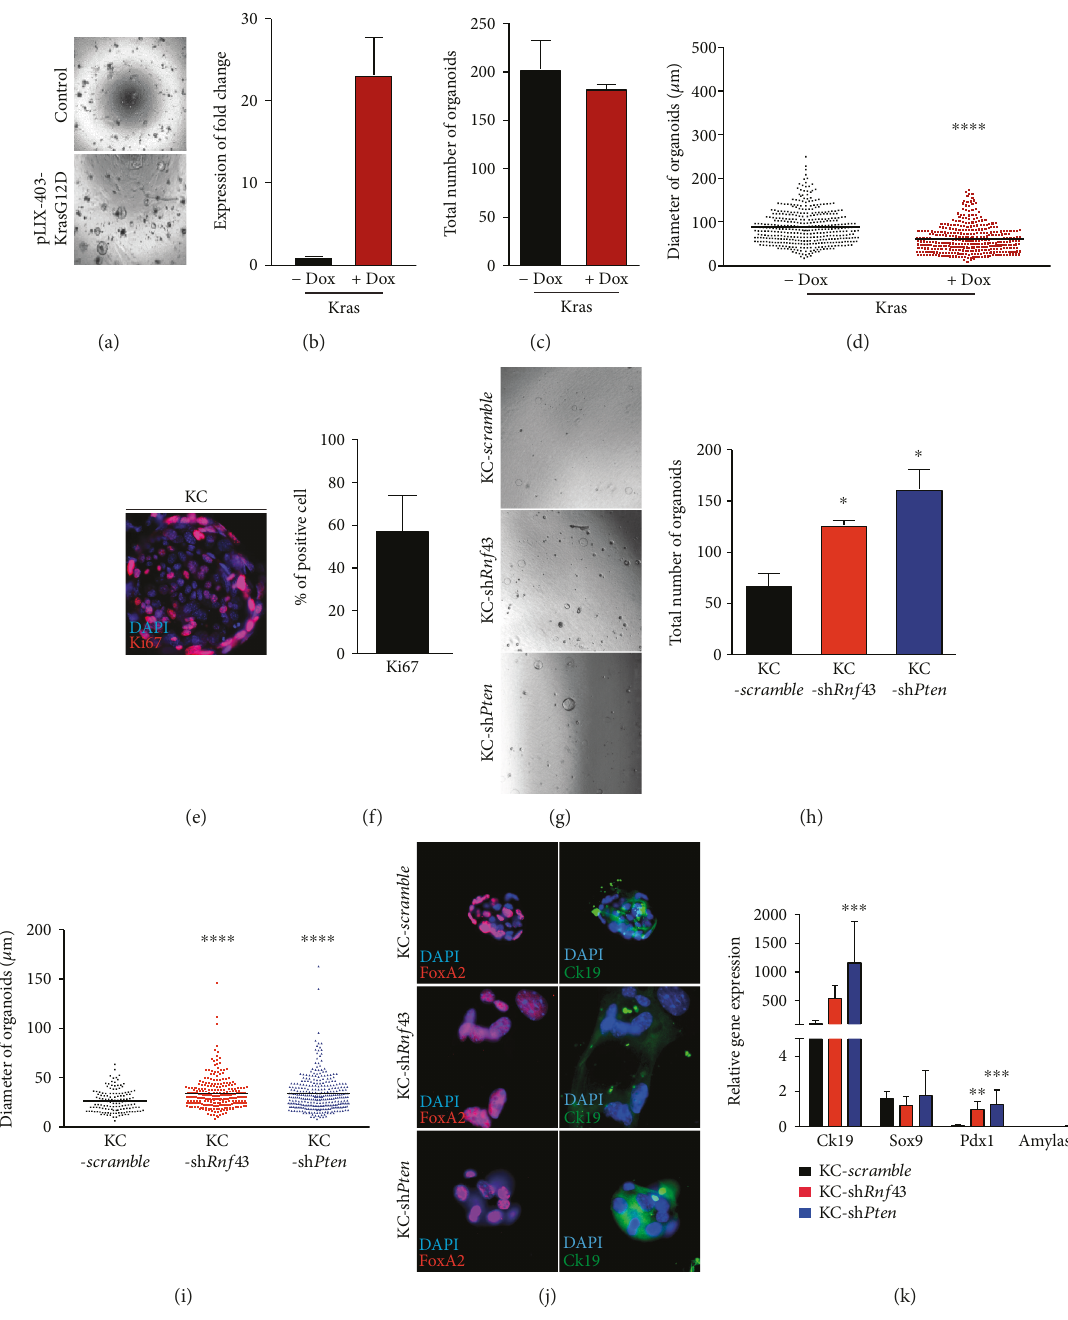
Figure 3: Oncogenic Kras fosters proliferation in PTEN- and RNF43-de fi cient ductal organoids. (a) Doxycycline-inducible KRAS G12D (pLIX-403-KRAS G12D ) and control organoids are morphologically similar after six days of culture (40x magni fi cation). (b) KRAS G12D expression can be induced by doxycycline application in the pLIX-403-KRAS G12D organoids. (c, d) KRAS G12D induction does not change the number of organoids but signi fi cantly the size compared to control ( p ≤ 0 0001 ). (e, f) In total, 57.6% of the cells are positive for Ki-67 (400x magni fi cation). (g) Representative pictures of KC organoids with shRNA knockdown of Pten (KC-sh Pten ) or Rnf43 (KC-sh Rnf43 ) compared to KC scramble control after eight days of culture (40x magni fi cation). (h) Signi fi cant di ff erences are observed in the number of organoids for KC-sh Pten ( p = 0 0276 ) and KC-sh Rnf43 ( p = 0 0234 ) organoids compared to control. (i) The diameter of KC organoids is signi fi cantly increased after knockdown of Pten ( p < 0 0001 ) and Rnf43 ( p < 0 0001 ). (j) Immuno fl uorescence staining of FOXA2 and CK19 in KC organoids with either shRNA-mediated knockdown of Pten (KC-sh Pten ) or Rnf43 (KC-sh Rnf43 ) (400x magni fi cation). (k) Relative gene expression levels are signi fi cantly elevated for CK19 ( p = 0 0004 ) and PDX1 ( p = 0 0006 ) in KC-sh Pten (blue bar) and for PDX1 ( p = 0 037 ) in KC-sh Rnf43 (red bar) compared to KC scramble (black bar). Amylase is not expressed. For statistical analysis, two-tailed Student ’ s t -test was used. p < 0 05 was considered to be statistically signi fi cant. Error bars represent the standard errors of the